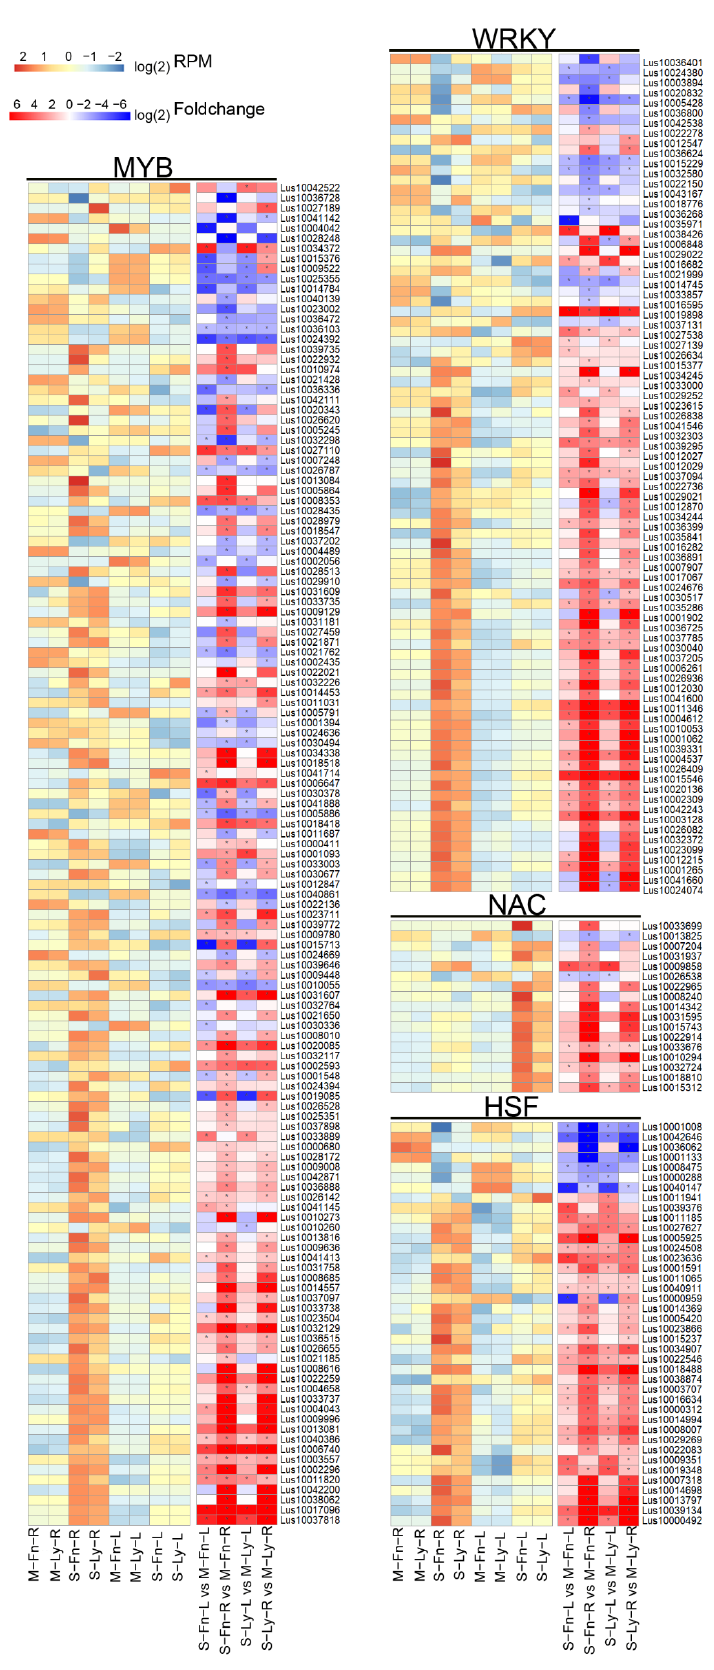
Figure 7. Expression of genes related to TFs between root and leaf in Fanni and Longya10 under saline stress. M–Fn–R and M–Ly–R represent the root samples derived from Fanni and